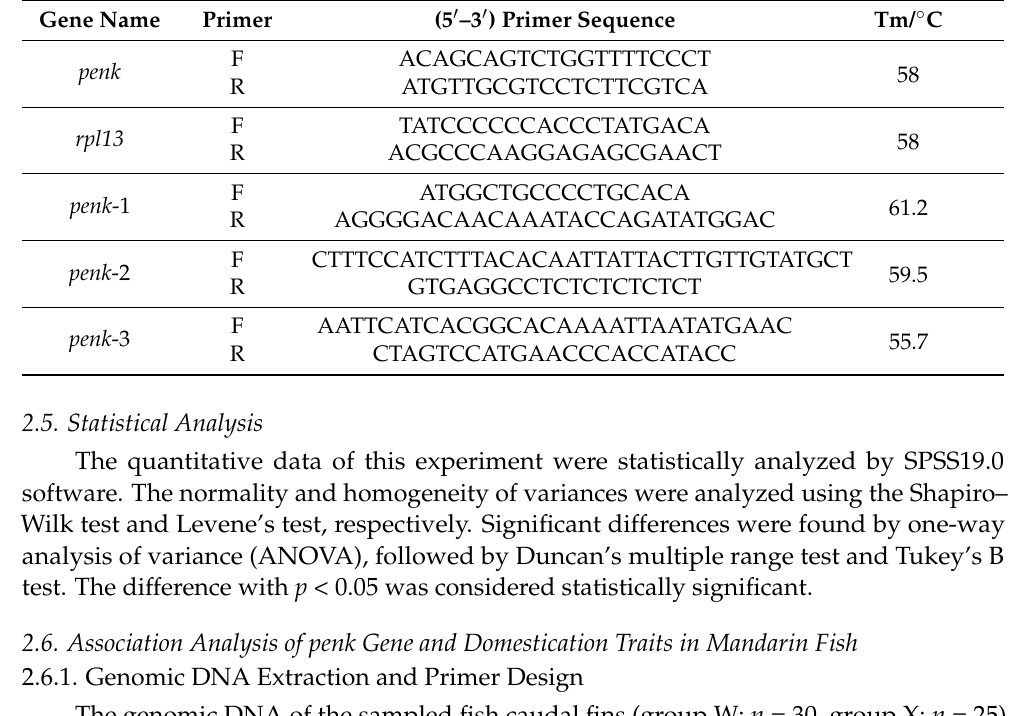
Table 2. The amplification primer sequence of the penk